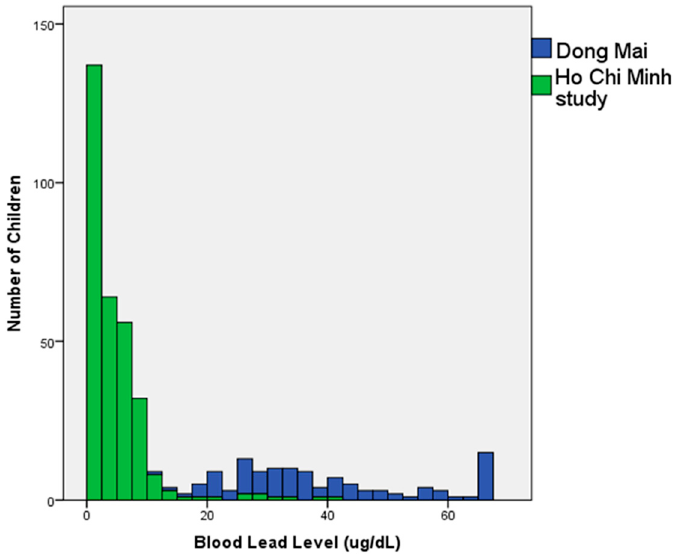
Figure 2. Comparison of child BLLs from the Dong Mai study ( n = 109) [16] and Ho Chi Minh City ( n = 311).